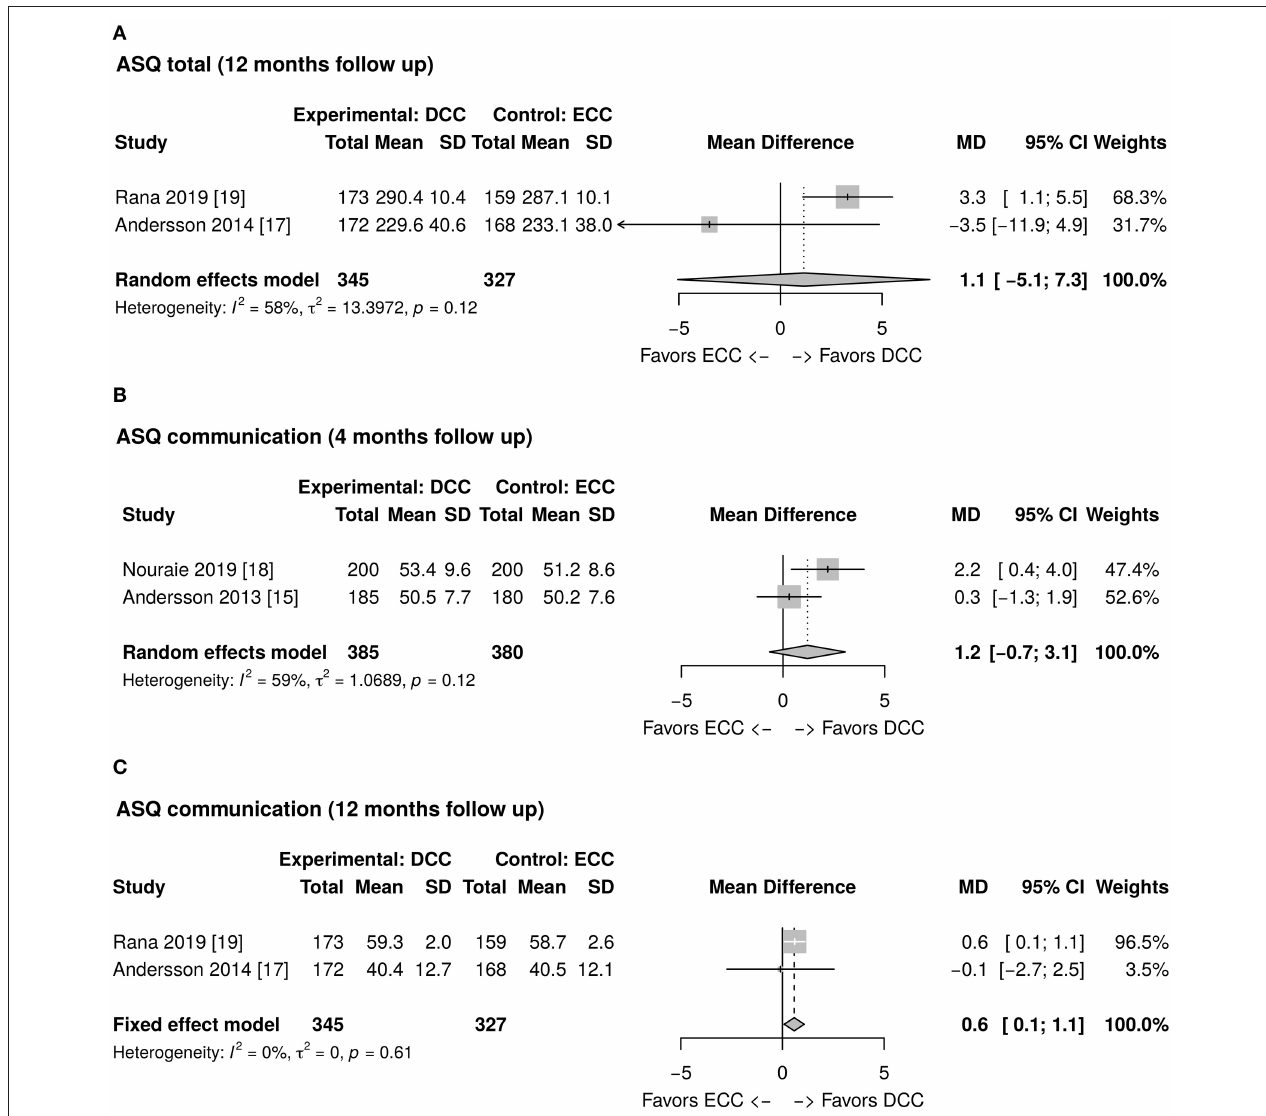
FIGURE 2 | (A) Forest plot showing mean difference of the Ages and Stages Questionnaire (ASQ) total score at 12 months follow up between delayed cord clamping (DCC) and early cord clamping (ECC) groups. (B) Forest plot showing mean difference of the ASQ communication domain score at 4 months follow up between DCC and ECC groups. (C) Forest plot showing mean difference of the ASQ communication domain score at 12 months follow up between DCC and ECC